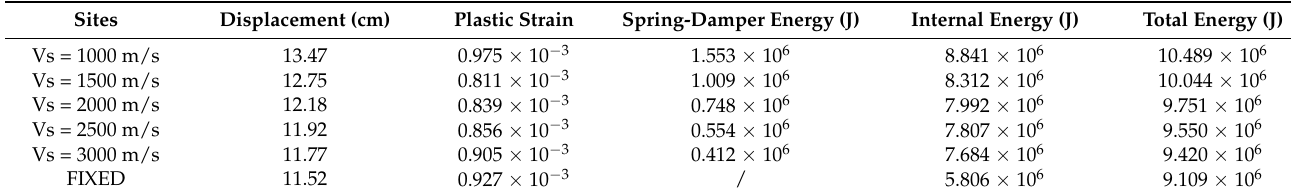
Figure 11. Contours of the maximum plastic strain of concrete of full SC containment for different site conditions. ( a ) Vs